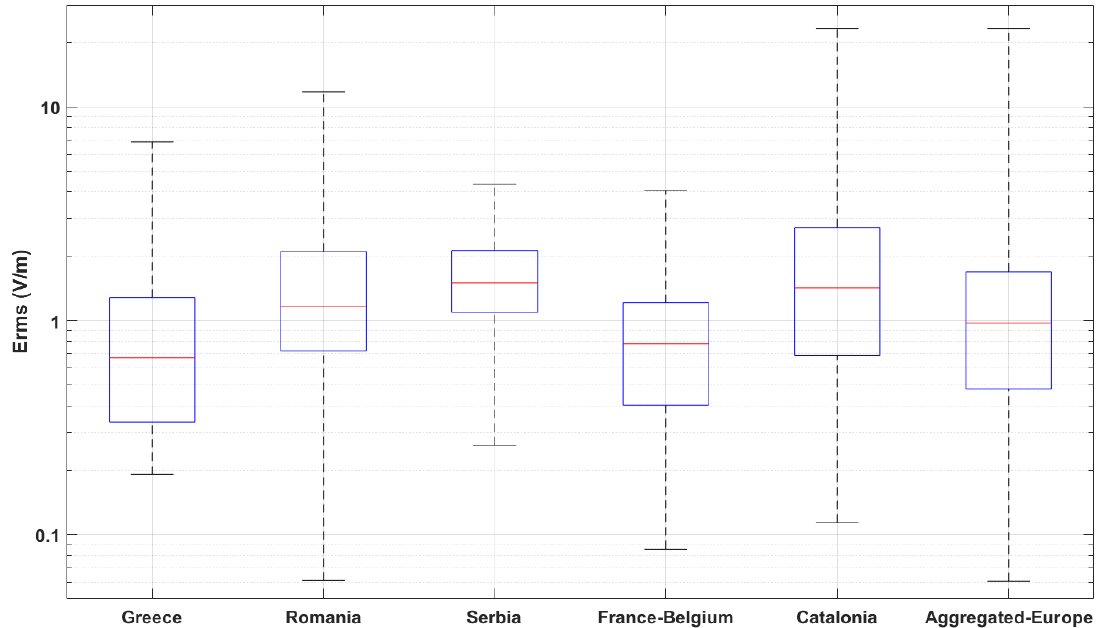
Figure 1. Boxplot charts for the distributions of monitoring sensors’ Erms (V/m) value: median values (red lines), interquartile ranges (blue boxes), and full range (min–max) of distributions (dashed lines).